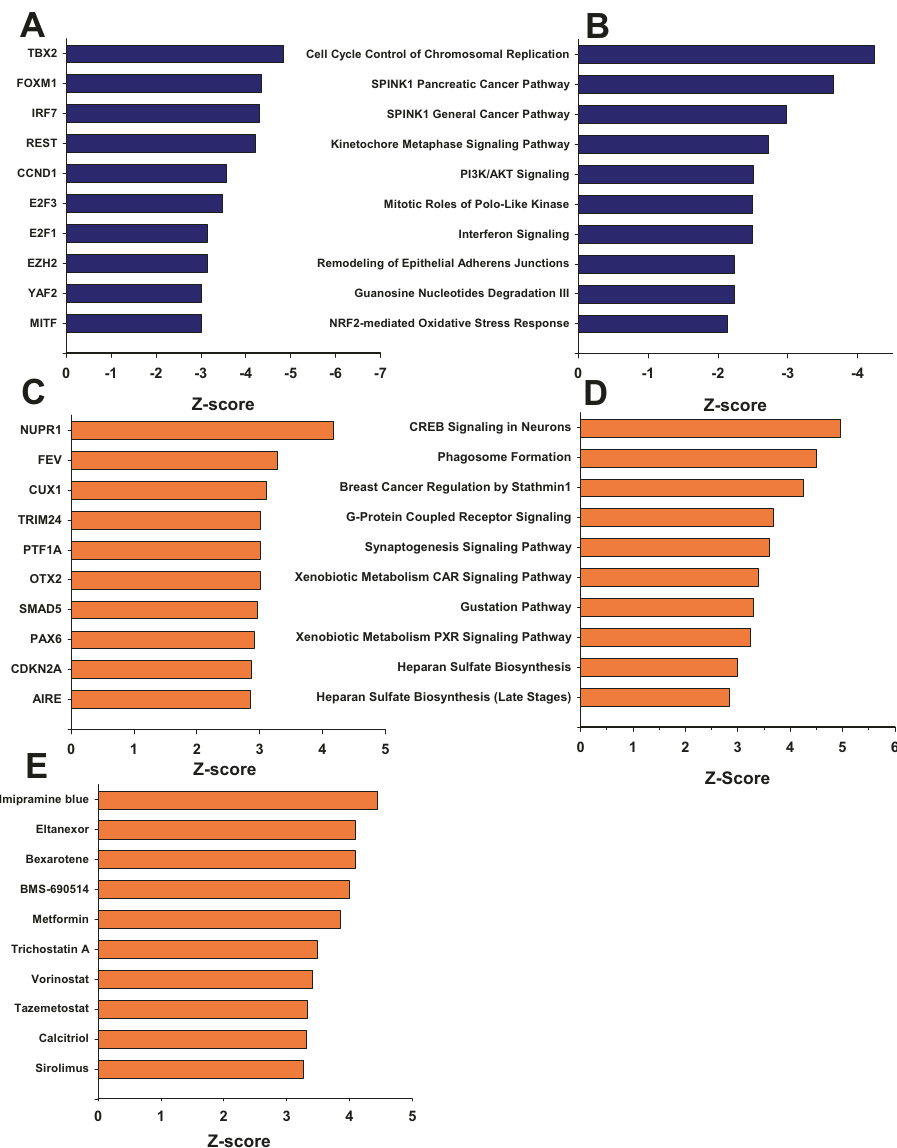
Fig. 9 Pathway and upstream analysis during the reversal of ADM by TSA in KC acinar cells. RNA sequencing data from the ADM reversal in KC mouse acini following 500 nM TSA treatment was analyzed using Ingenuity Pathway Analysis. A , C Top 10 transcription factors involved in the upstream regulation ranked by Z-score. B , D Most highly ranked signaling pathways ranked by Z-score. E Top 10 chemical drugs predicted to regulate the signaling pathways. Blue, inhibited and orange, activated